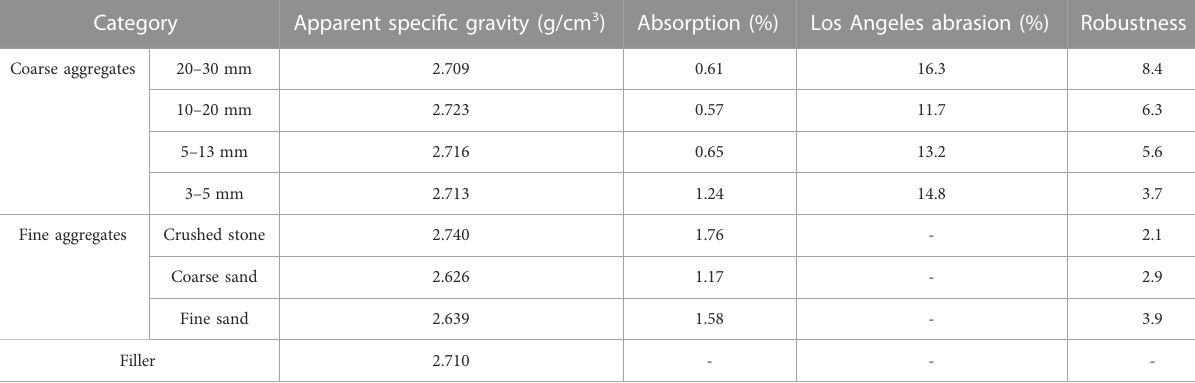
TABLE 2 Technical indexes of aggregates.